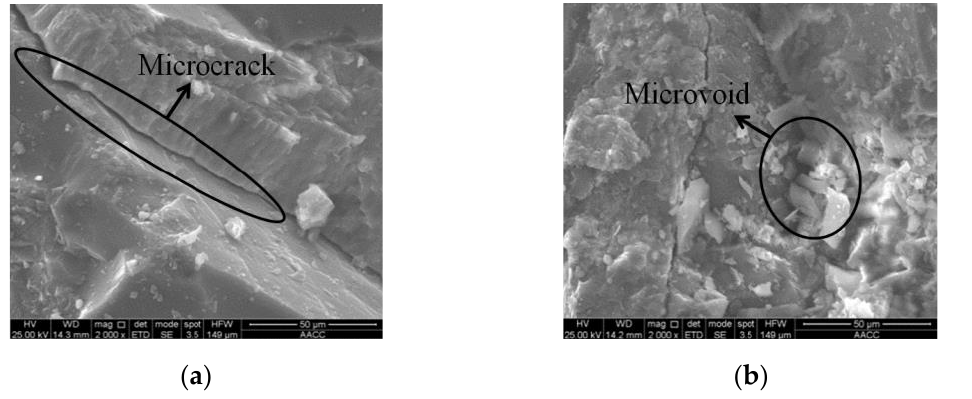
Figure 1. Scanning electron microscopy (SEM) photos at 2000 × magnification of sandstone samples. SEM Quanta TM 250 FEG was used for materials characterization. ( a ) Microcracks in sandstone. ( b ) Microvoids in sandstone.